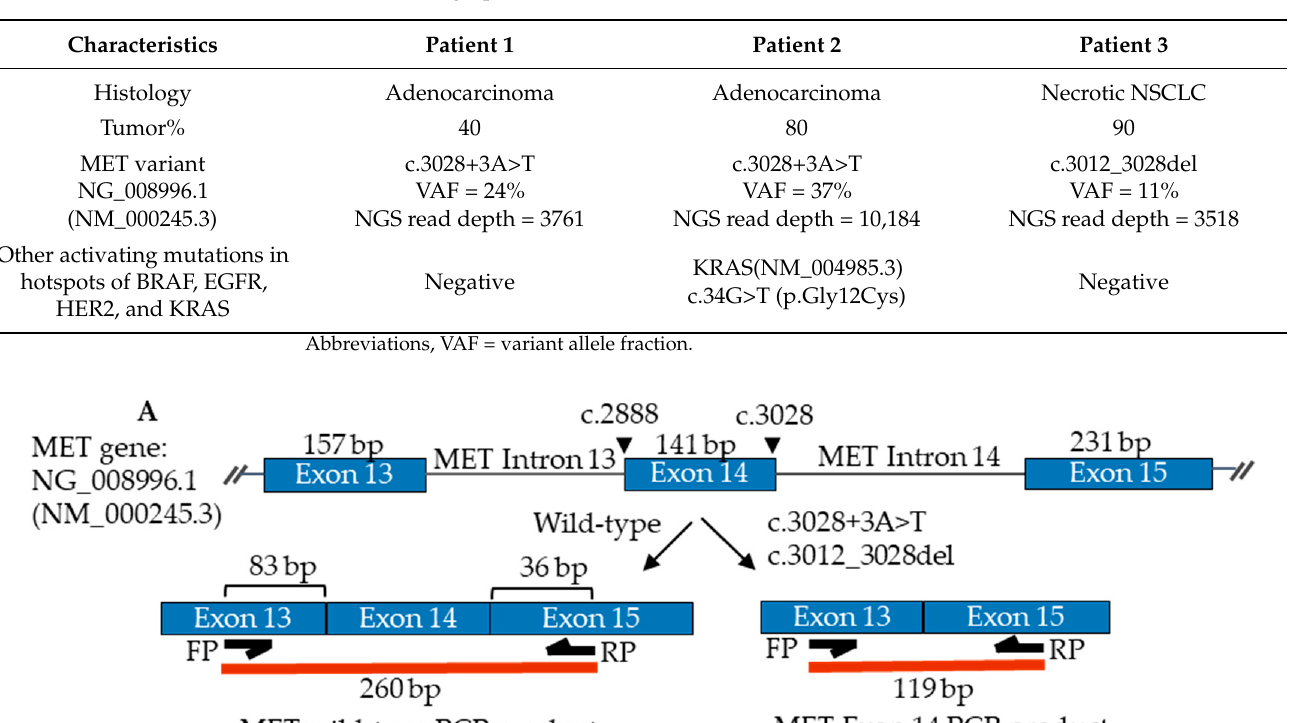
Table 1. Demographic and clinical characteristics.